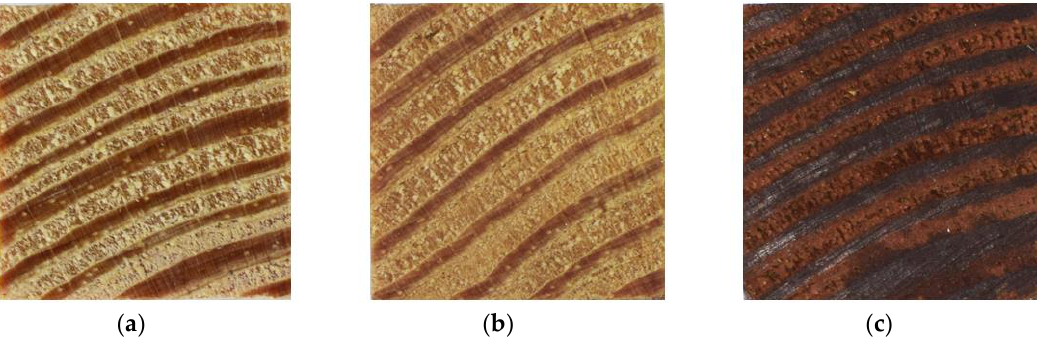
Figure 1. Images of partial heat-treated wood samples. ( a ) Untreated southern yellow pine, ( b ) heat treated at 140 °C, ( c ) heat treated at 220 °C.